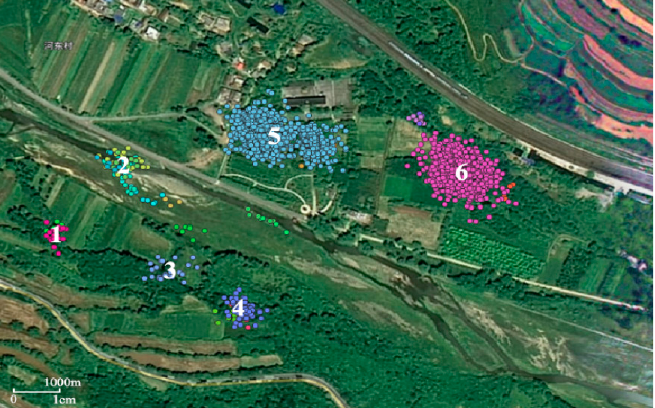
Figure 2. Identification results of the crested ibis’s high-frequency stopping points based on the spatial threshold. Different colors represent different high-frequency stopping areas at different times from 2 January 2015 to 2 January 2016, marked from 1 to 6, respectively.